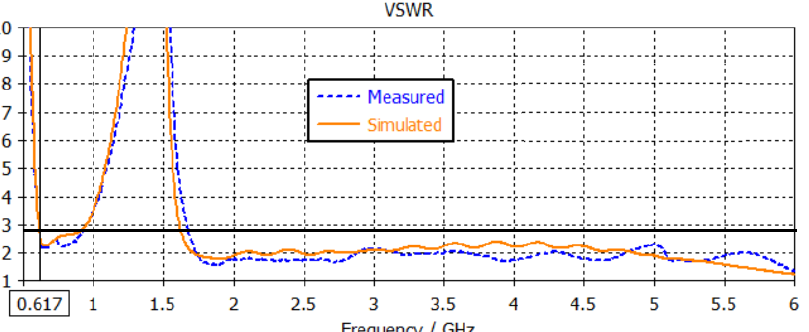
Figure 14. Comparison of measured and simulated VSWR.